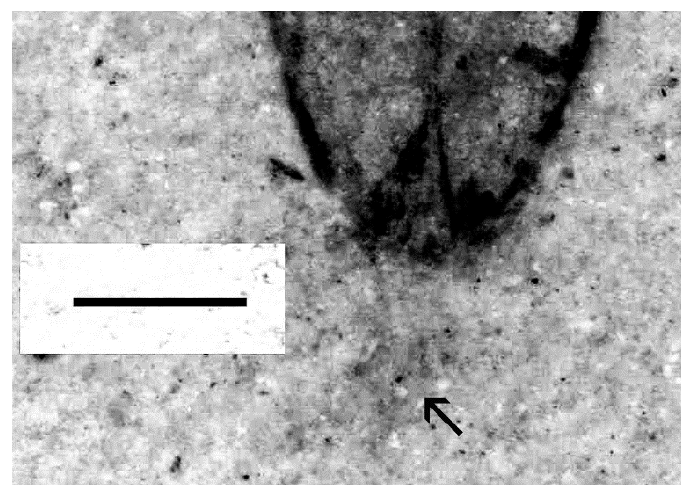
Figure 4. Apoclion antennatus Chang, Kirejtshuk & Ren, holotype. Elytral apex, simple trilobed aedeagus exposed (arrow). Scale 1 mm.